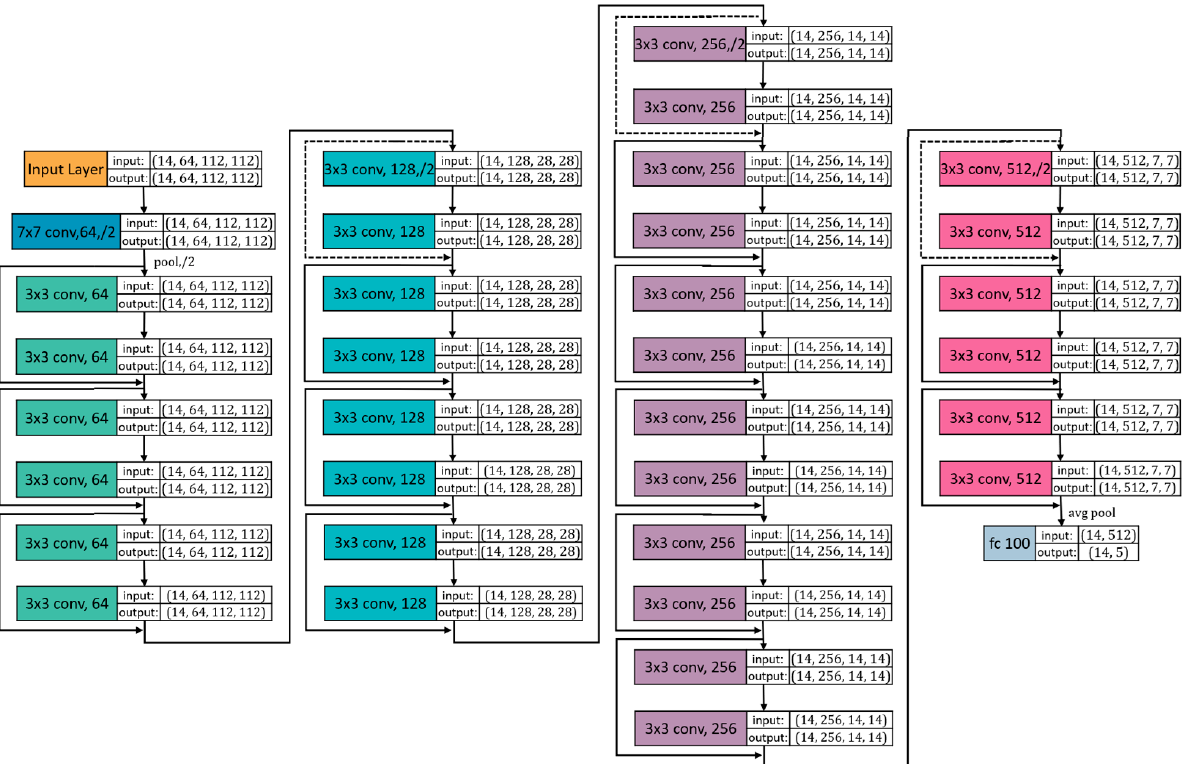
Figure 7. ResNet34 network architecture and parameters at each layer.